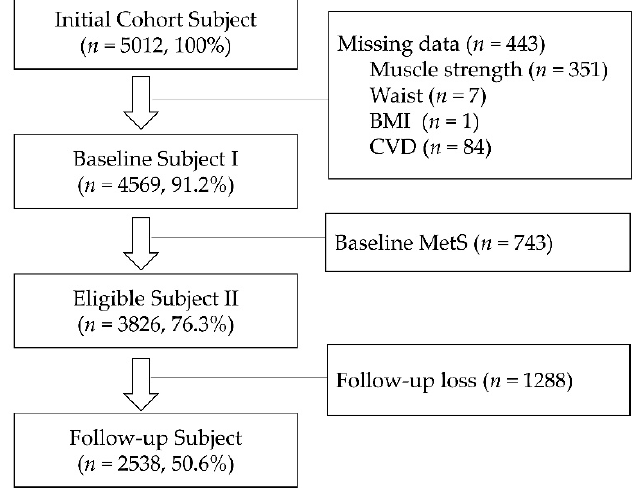
Figure 1. Participant flowchart.